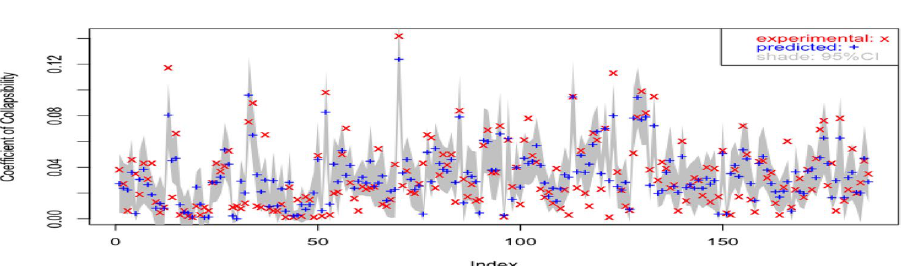
Figure 17. Generalised additive model validation: samples from Lv Liang; ( a ) Predicted vs experiment, ( b ) QQ-plot for residual checks.